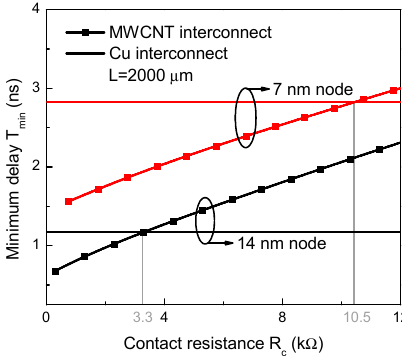
Figure 12. Minimum time delay versus contact resistance for 2000 μ m-long Cu and MWCNT interconnects [87].